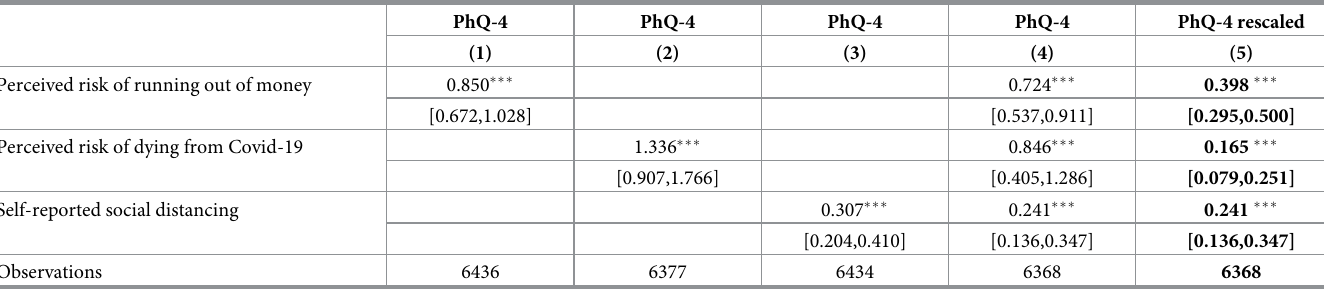
Table 3. Associations with mental health score